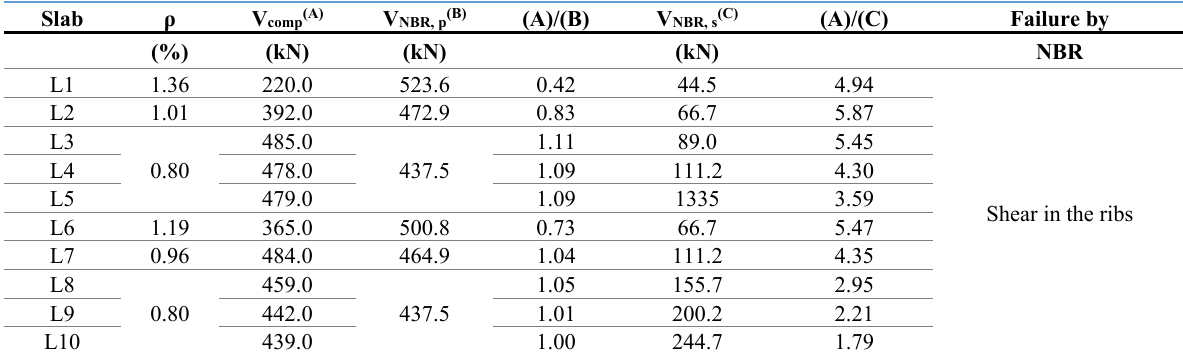
Table 6. Computational and NBR 6118 [5]